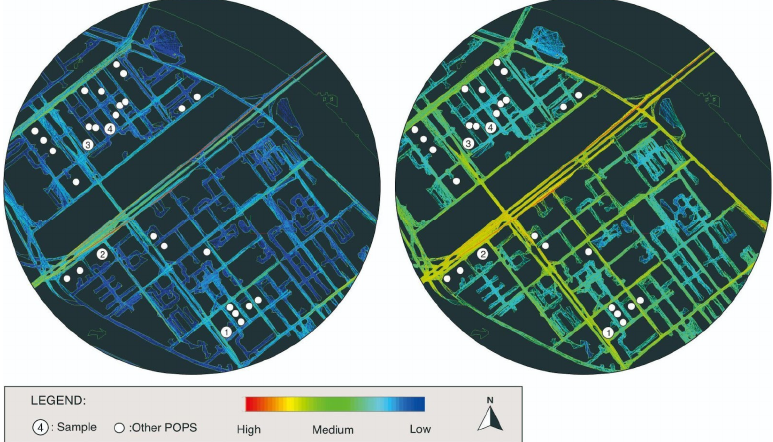
Figure 6. The axial map analysis showing the connectivity ( left ) and integration ( right ) of the urban fabric of YBD.